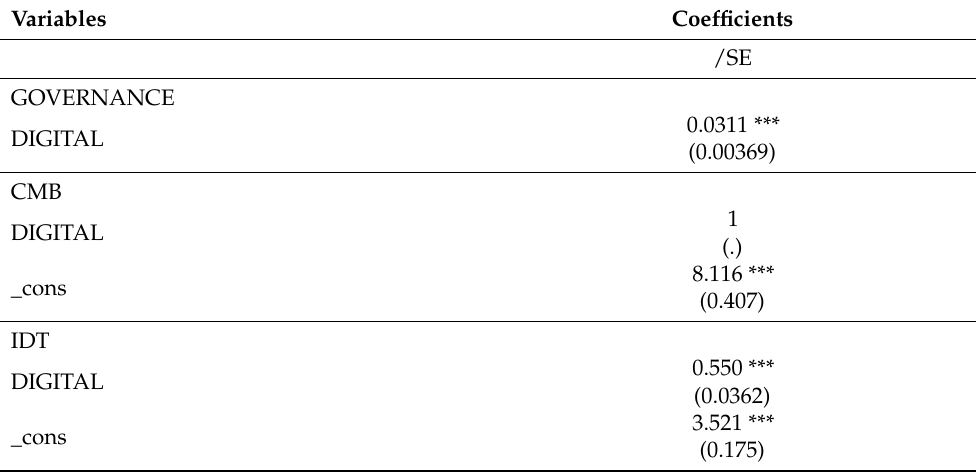
Table A1. Detailed SEM results, maximum likelihood method (with missing